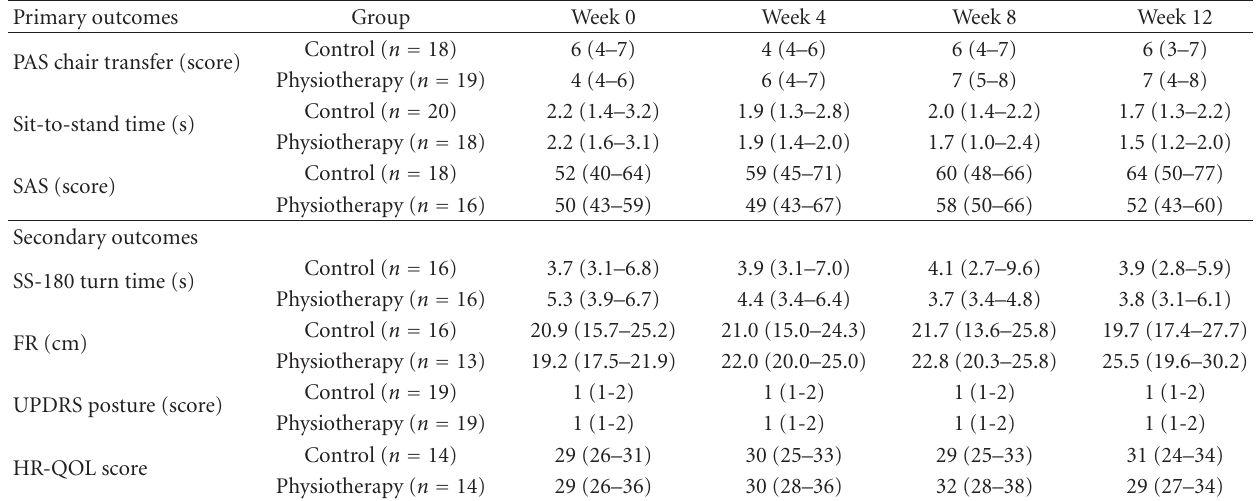
Table 2: Changes in outcomes (weeks 0–12, by group) in participants who completed a measure on at least three occasions; values presented are medians (interquartile